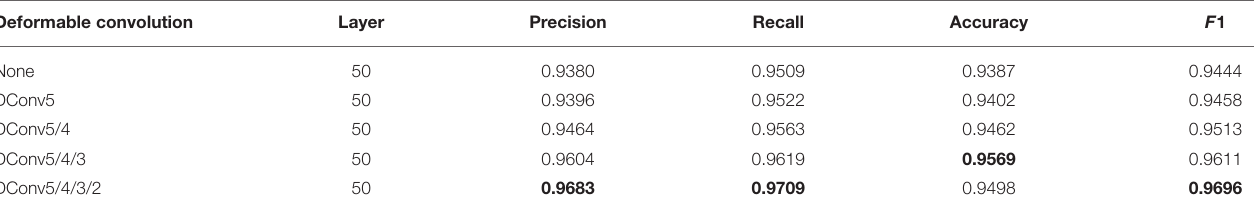
TABLE 3 | The experimental results of the ablation analysis of deformable convolution, the higher the values of precision, recall, accuracy, and F 1, the better the recognition performance. Deformable convolution Layer Precision Recall Accuracy F 1